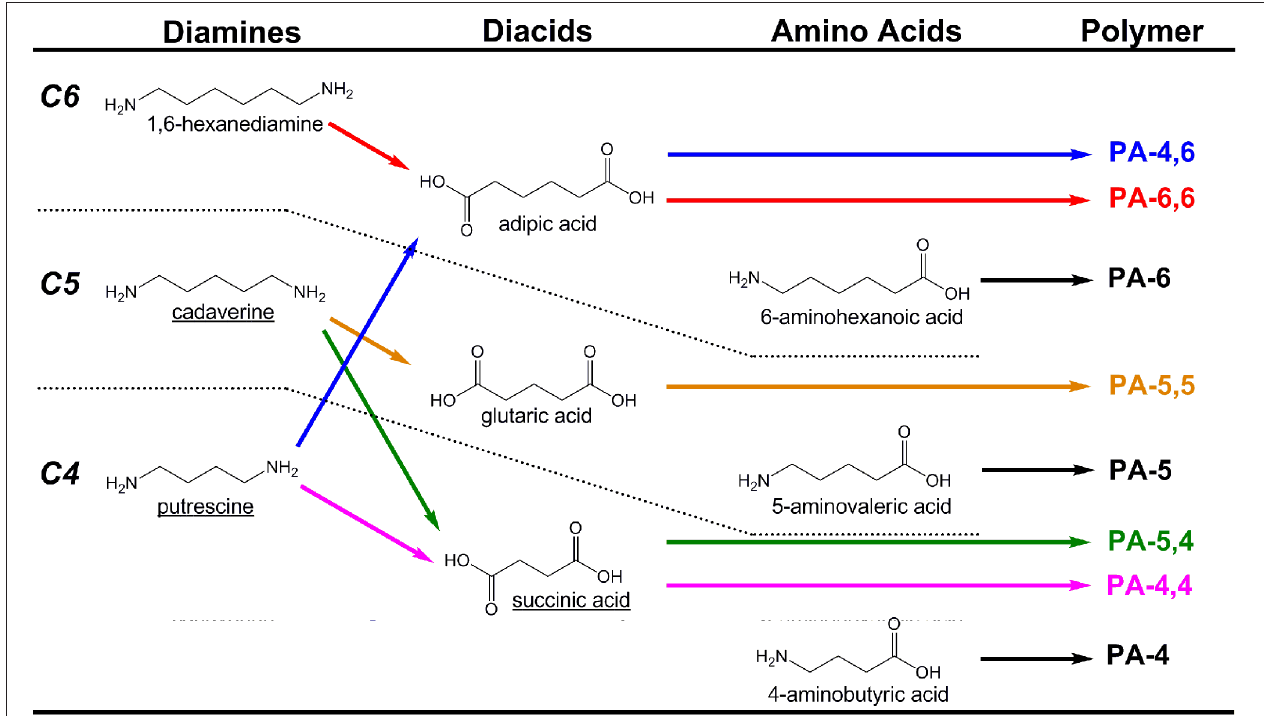
FIGURE 3 | Examples of polyamides (PAs) produced from combinations of C4–C6 diamines, diacids, and amino acids. To date, molecules with names underlined have been produced microbially from renewable resources with the aid of metabolic